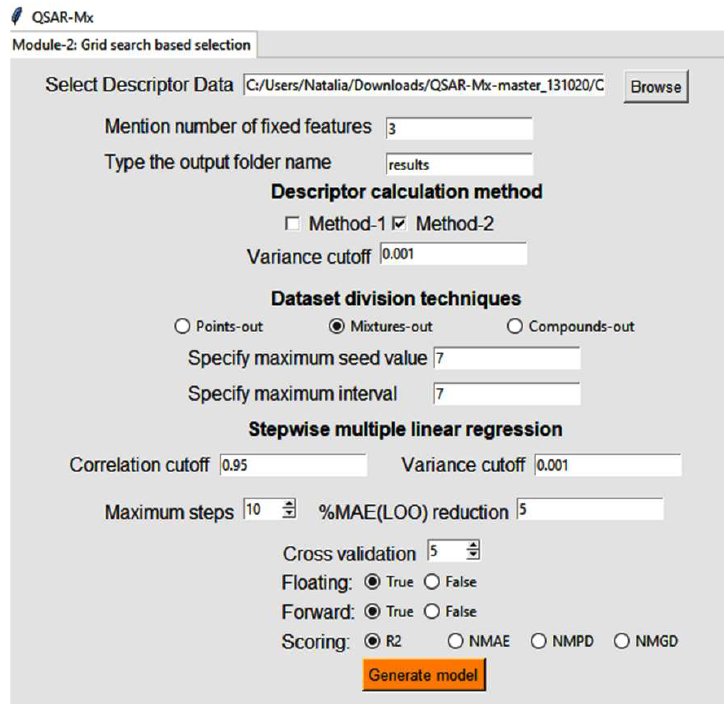
Figure 1. Screenshot of the in-house, publicly accessible tool QSAR-Mx, used for setting up the presented QSPR models.